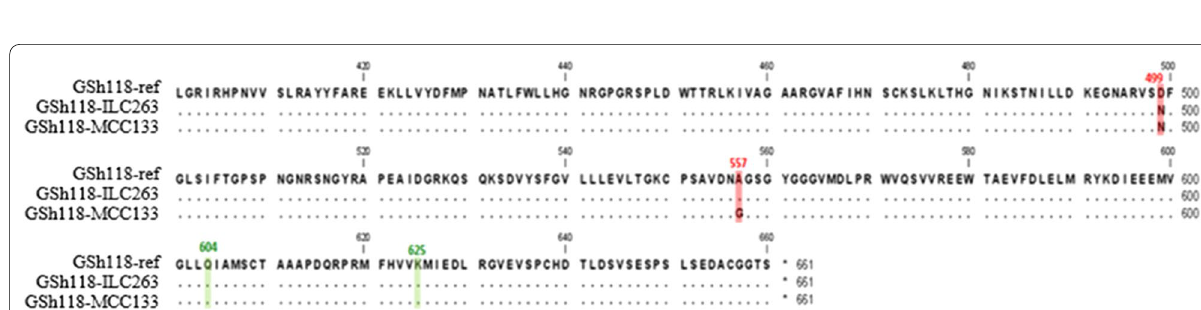
Fig. 5 Regional protein sequence alignment comprising the identified SNPs of two chickpea lines; MCC133 (resistant) and ILC263 (sensitive) in comparison with the protein sequence predicted in the gene bank (XP_012570257.1). Numbers on the sequences are the amino acid positions from the beginning of the protein. Dark backgrounds show the position of SNPs in the codon. The positions 499 and 557 are corresponded to SNP18-2147 and SNP18, expressed at the protein level. The positions 604 and 625 related to SNP18-2491 and SNP18-2554 are not expressed at the protein level. Similar sequences are shown as